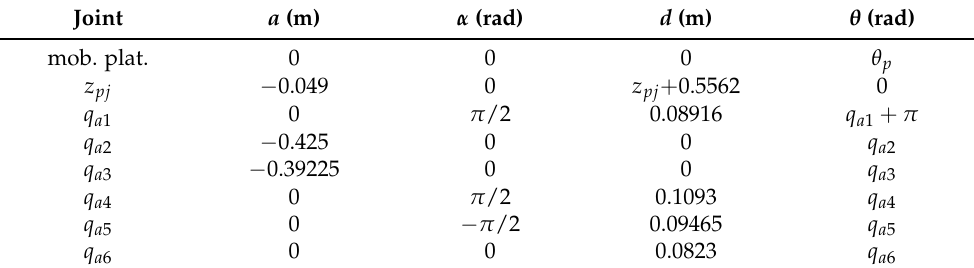
Table 1. D-H parameters.